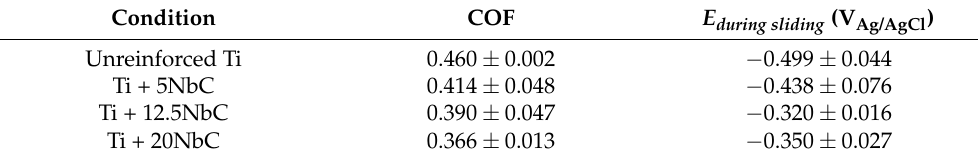
Table 4. Average values of COF and potential during sliding performed under OCP.